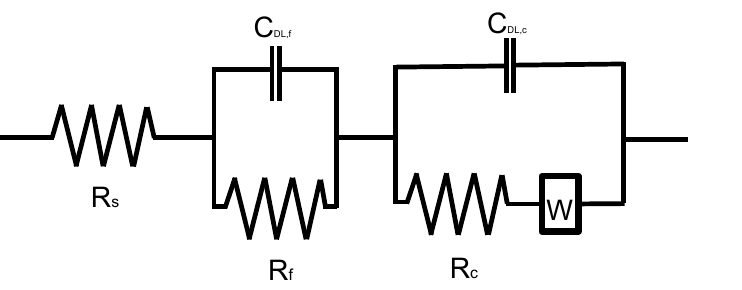
Figure 6. Equivalent electrical circuit models for modelling corrosion of steel in concrete considering electrochemical deposit in concrete.